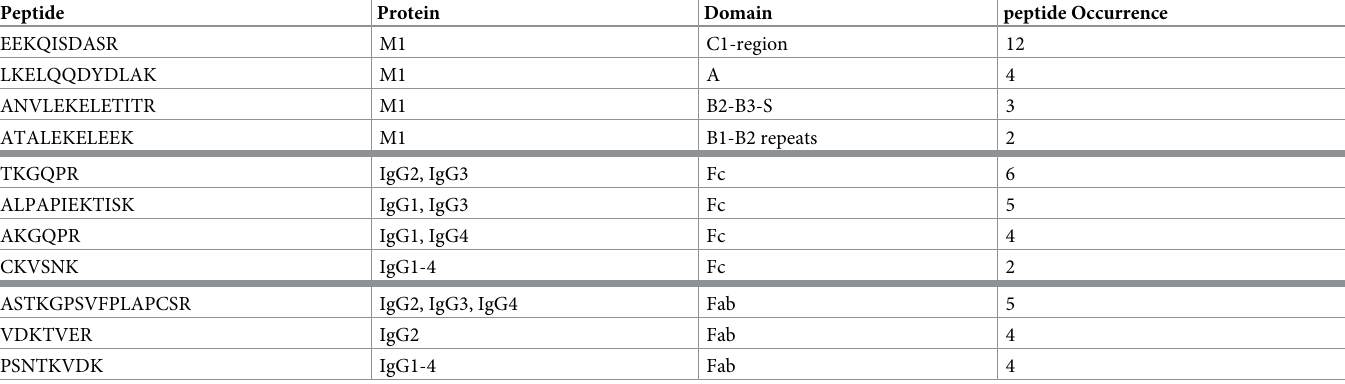
Table 1. Peptides with high-affinity binding occurrences. The listed peptides are frequent in the binding interfaces of the M1 protein and different IgGs according to the XL-MS quantification.